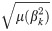
Heterogeneity of sequential effects in random sequence generation task, quantified using the coefficients of a logistic regression of memory size L = 10.A. The distribution of the coefficients across participants for the bias and lags 1–4 coefficients. The statistics of these coefficients are summarized in B, C and D for the mean (μ), magnitude (μ(βk2)) and the signal to noise ratio (SNR), respectively, as a function of the lag (k), where the bias terms (k = 0) is at the right of k = -1). Error bars represents the 95% confidence intervals computed by 100-fold bootstrapping (Bonferroni corrected for multiple comparison).